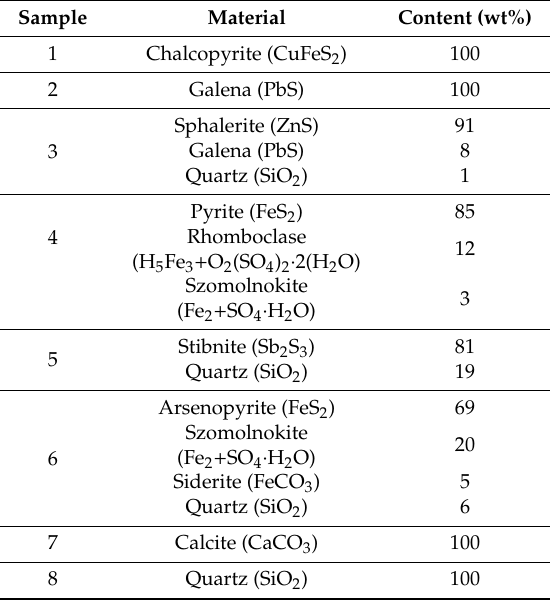
Table 2. Mineralogy of samples as determined by XRD.